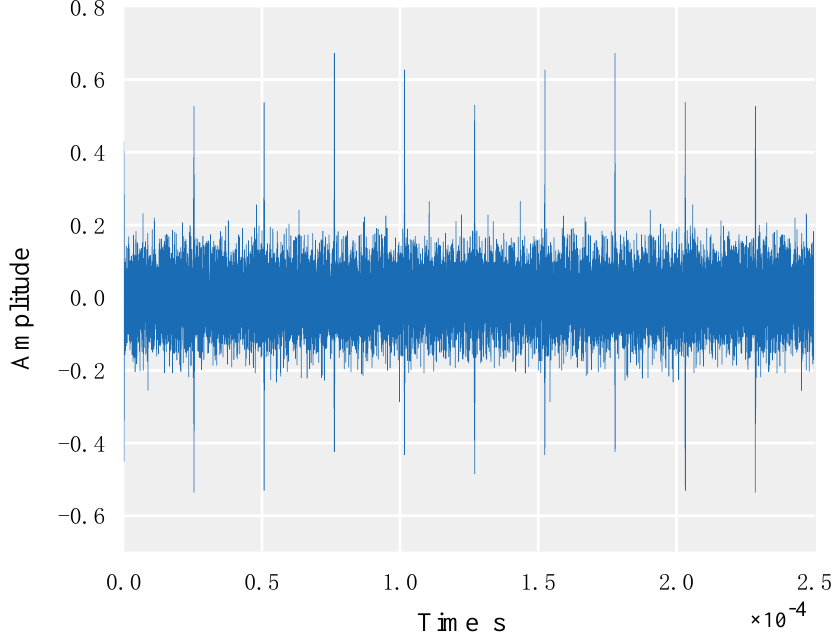
Figure 6. Second-order matrix of DSSS autocorrelation function.